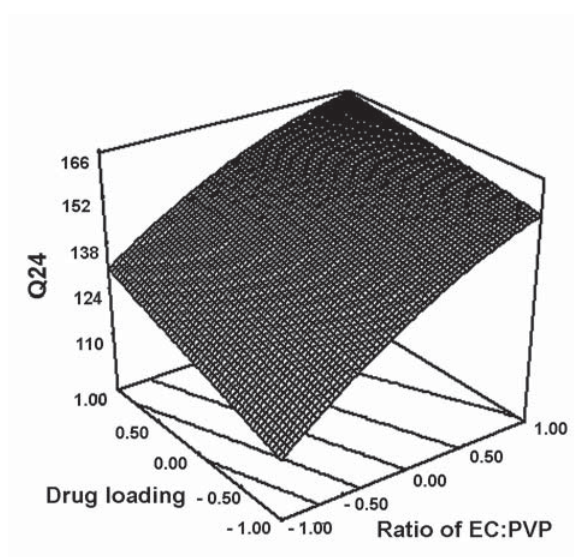
Figure 4 – Contour plot for amount of drug permeated per cm 2 of human cadaver skin at 24 h (Q ratio of EC: PVP and drug loading on Q